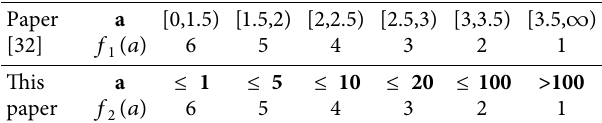
Table 9: Mapping functions.